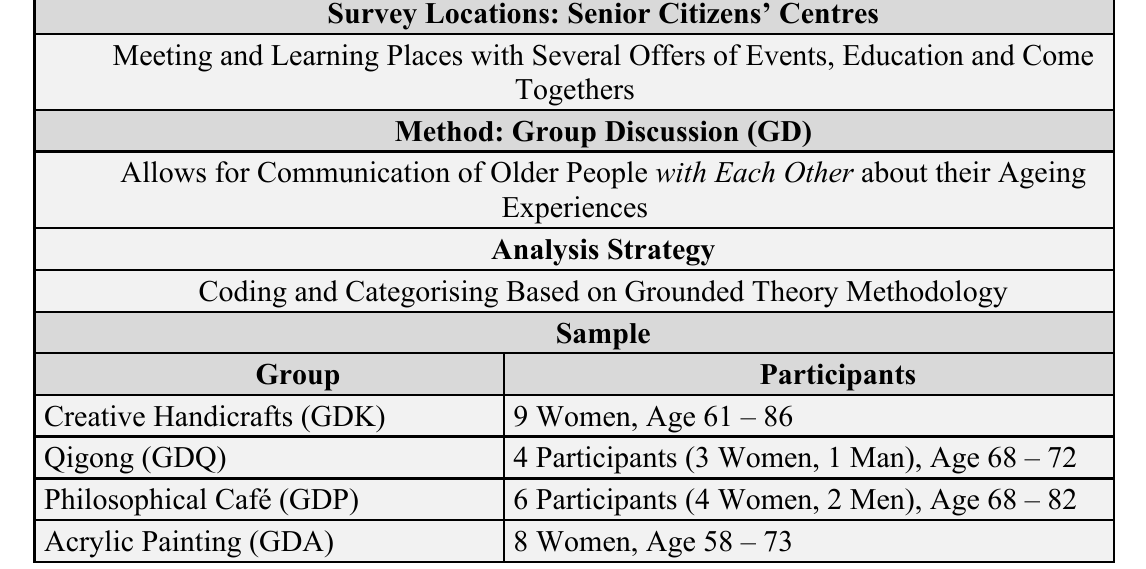
Table 1: Overview of the Empirical Survey Survey Locations: Senior Citizens’ Centres Meeting and Learning Places with Several Offers of Events, Education and